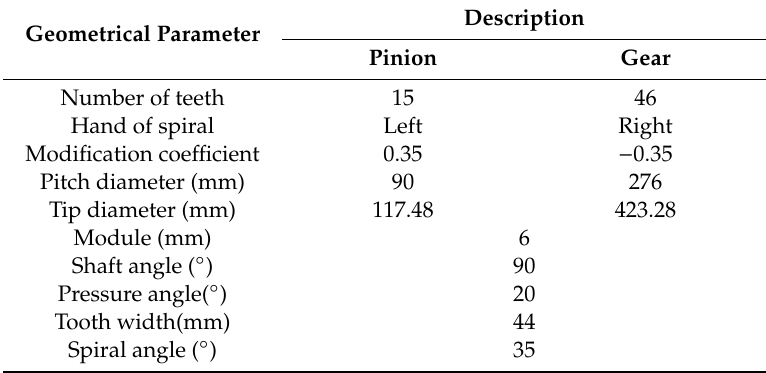
Table 1. Basic tooth geometric parameters.